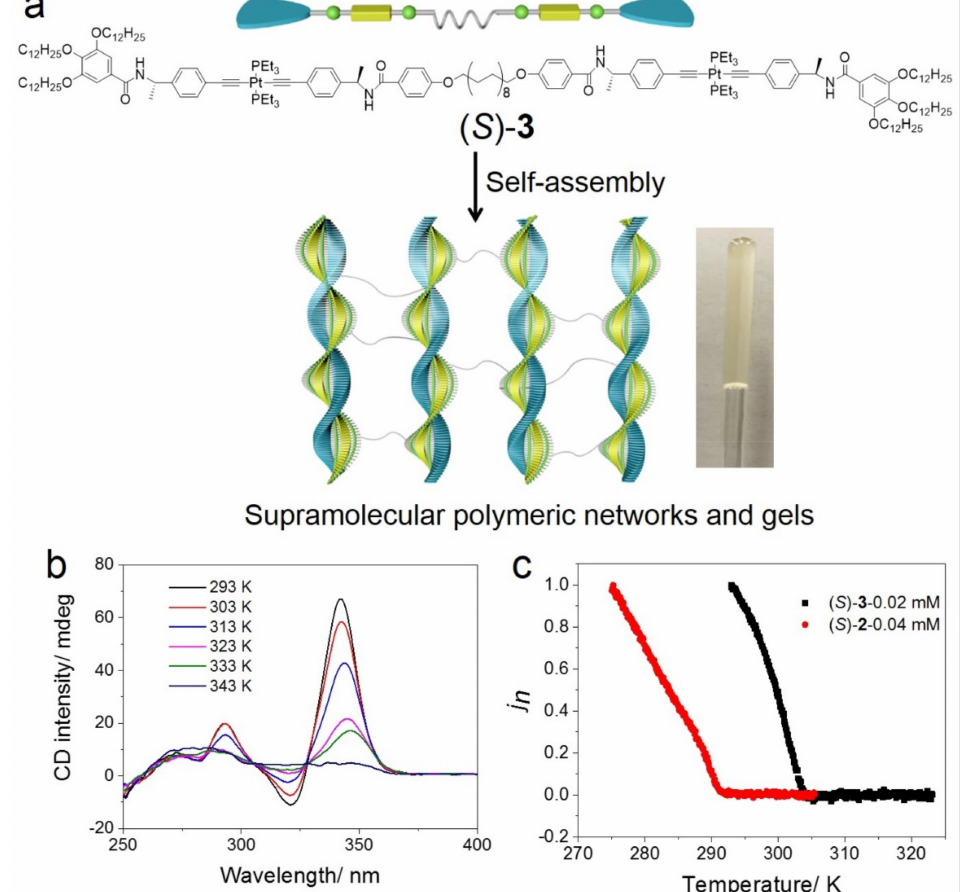
Figure 4. ( a ) Schematic representation for the construction of supramolecular polymeric networks and organogels derived from the ditopic monomer platinum(II) acetylide ( S )- 3 . ( b ) CD spectra of ( S )- 3 at different temperatures in MCH/TCE (99:1, v / v , c = 0.02 mM). ( c ) Net helicity ϕ n as a function of temperature for ( S )- 3 (red line, 0.02 mM, λ = 342 nm) and ( S )- 2 (black line, 0.04 mM, λ = 350 nm) in MCH/TCE (99:1, v / v